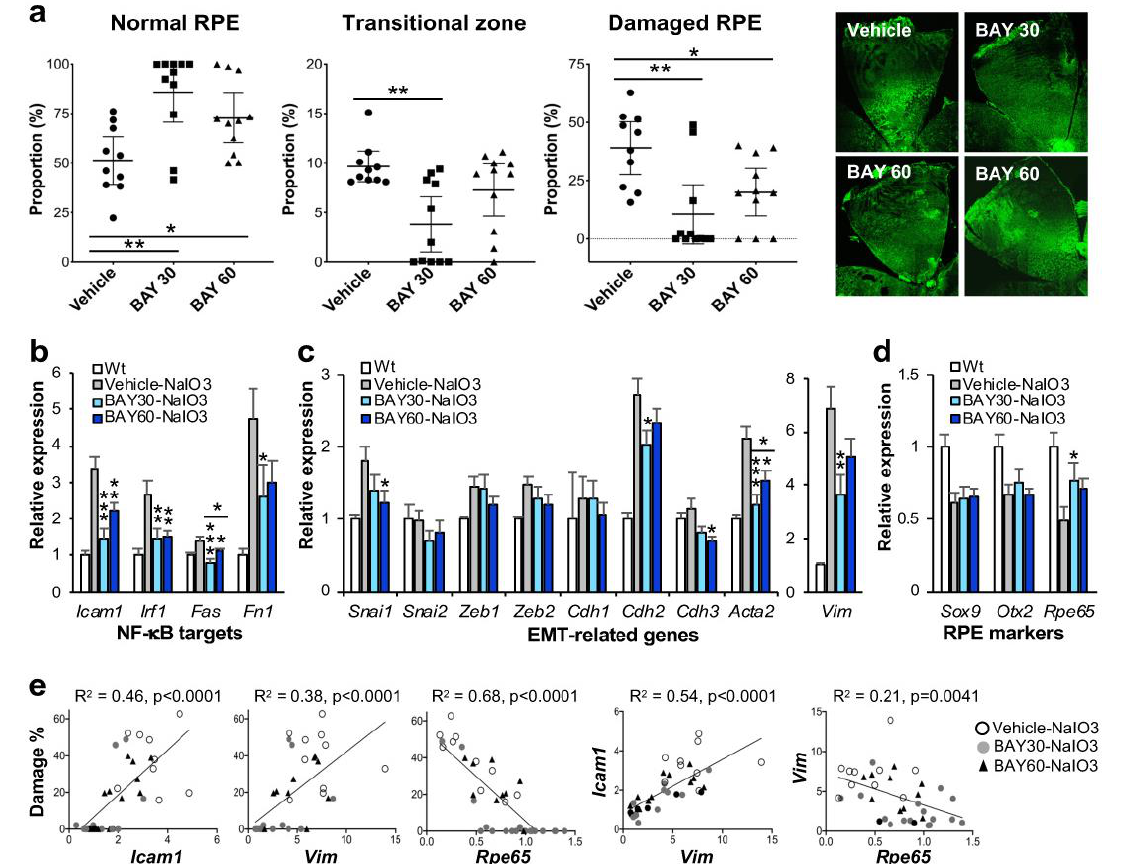
Figure 2. IKK β inhibitor BAY 651942 protects RPE from NaIO 3 -induced oxidative stress in mice. ( a ) The effects of BAY 651942 on RPE damage caused by NaIO 3 in mice. Male C57BL/6J mice were given BAY 651942 or vehicle by oral gavage 12 and 1 h before and 4, 24, 48, and 72 h after injection of NaIO 3 at 16 mg/kg BW via tail vein. Mouse eyes were analyzed 7 days after NaIO 3 injection as described in Figure 1. The proportions (%) of the three regions, normal RPE (periphery), elongated RPE (transitional zone), and severely damaged RPE (center), were calculated compared to the entire RPE. The results for mice with BAY 651942 at 30 mg/kg BW (BAY 30) or 60 mg/kg BW (BAY 60) were compared with those with vehicle. The values represent the means (horizontal lines) and 95% confidence intervals (error bars). Statistical significance was analyzed by one-way ANOVA and is shown by * p < 0.05 and ** p < 0.01. On the right, representative images of RPE flat-mounts with ZO-1 immunofluorescence (green) are shown from each group. Two images for BAY 60 are shown, one with no RPE damage (left) and the other with mild damage in the center (right). BAY 651942 significantly protected mouse RPE from NaIO 3 particularly at 30 mg/kg BW. ( b – d ) The effects of BAY 651942 on gene expression changes caused by NaIO 3 in mice. The contralateral eyes were analyzed by RT-qPCR for expression of genes in three categories: NF- κ B targets ( b ), EMT-related factors ( c ), and RPE markers ( d ). Relative expression in the experimental groups, vehicle, BAY 30, and BAY 60, was calculated as the ratio to the expression level in wild-type (Wt) mice. The values represent the means and SEM (error bars). Statistical significance is shown by * p < 0.05, ** p < 0.01, and *** p < 0.001. BAY 651942 significantly inhibited the upregulation of NF- κ B targets and EMT markers Acta2 ( α -SMA) and Vim (vimentin) compared with vehicle. ( e ) Correlation between RPE damage and gene expression in individual mice. Relative expression of selected genes in ( b – d ) were plotted against RPE damage in ( a ) from the same mice and analyzed by linear regression (left 3 panels). Relative expression between two genes was also analyzed by linear regression (right 2 panels). RPE damage was positively correlated with the mRNA level of Icam1 and Vim, and negatively correlated with that of